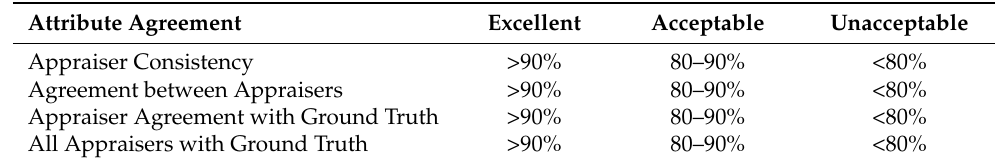
Table 1. Agreement acceptance limits as per AS13100 [54].